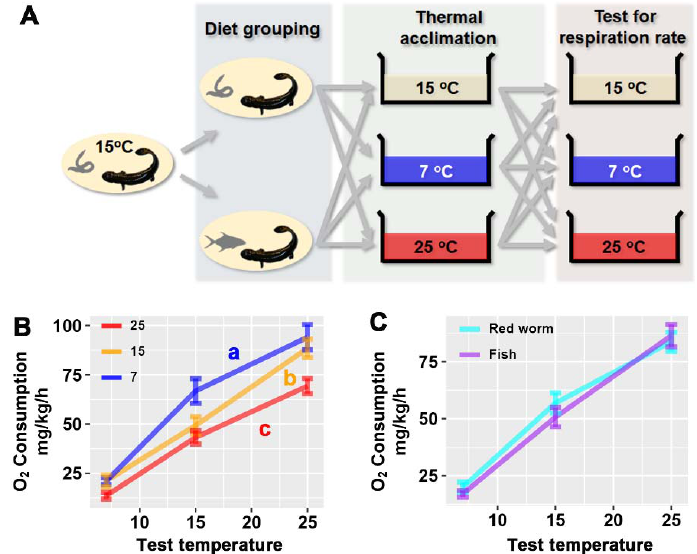
Figure 1. Plasticity in metabolic capacity after thermal and diet acclimation. ( A ) Experimental design. ( B ) Variations between thermal-acclimated groups. ( C ) Variations between diet-acclimated groups. The data were analyzed by ANCOVA (test temperature as covariant) and LSD post hoc test; the results are detailed in Table 2. Different letters denote significant differences between groups.